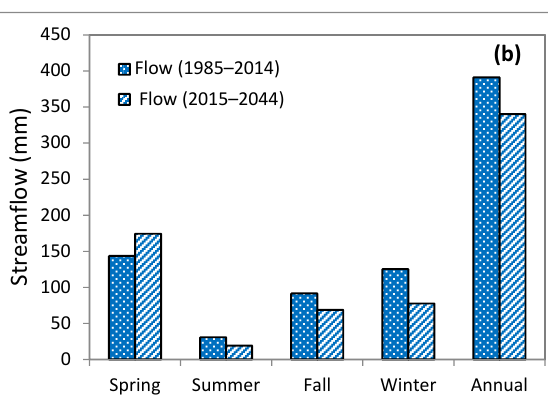
Figure 5. Historical and future simulated monthly ( a ) and seasonal ( b ) streamflow.